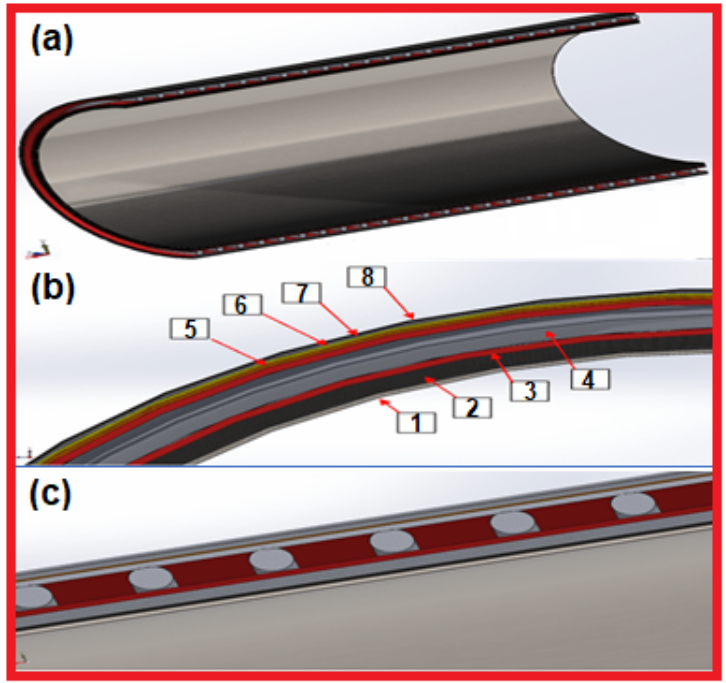
Figure 5. Cross-section through hose showing layers with the helix reinforcement in ( a ) open view, ( b ) closed view and ( c ) labelled section of layers for the liner (1), main plies (2), filler (3), steel helix (4), holding plies (5), subcover (6), filler (7) and main plies (8).